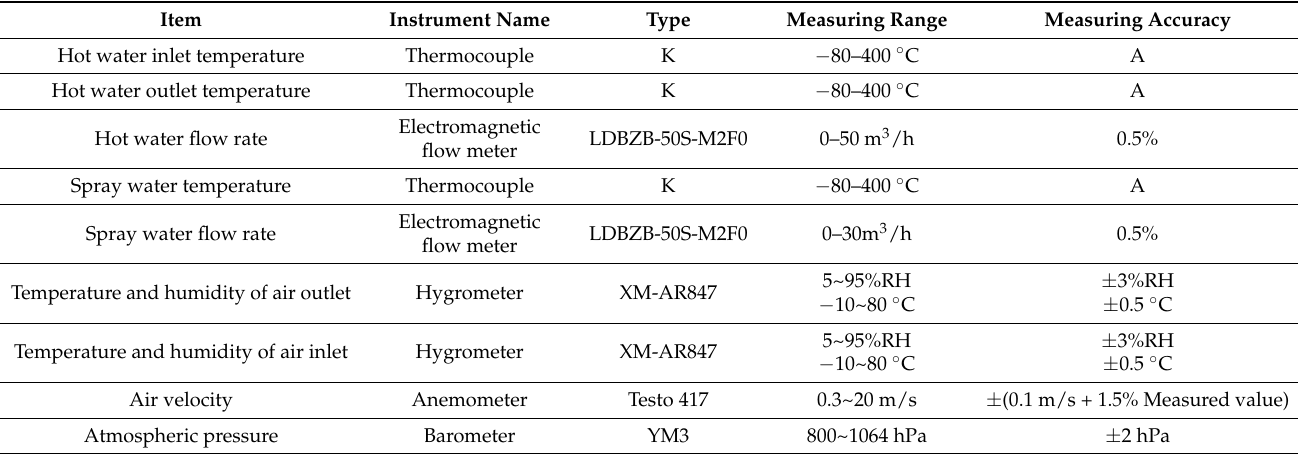
Table 1. The main experimental instruments used in the experimental